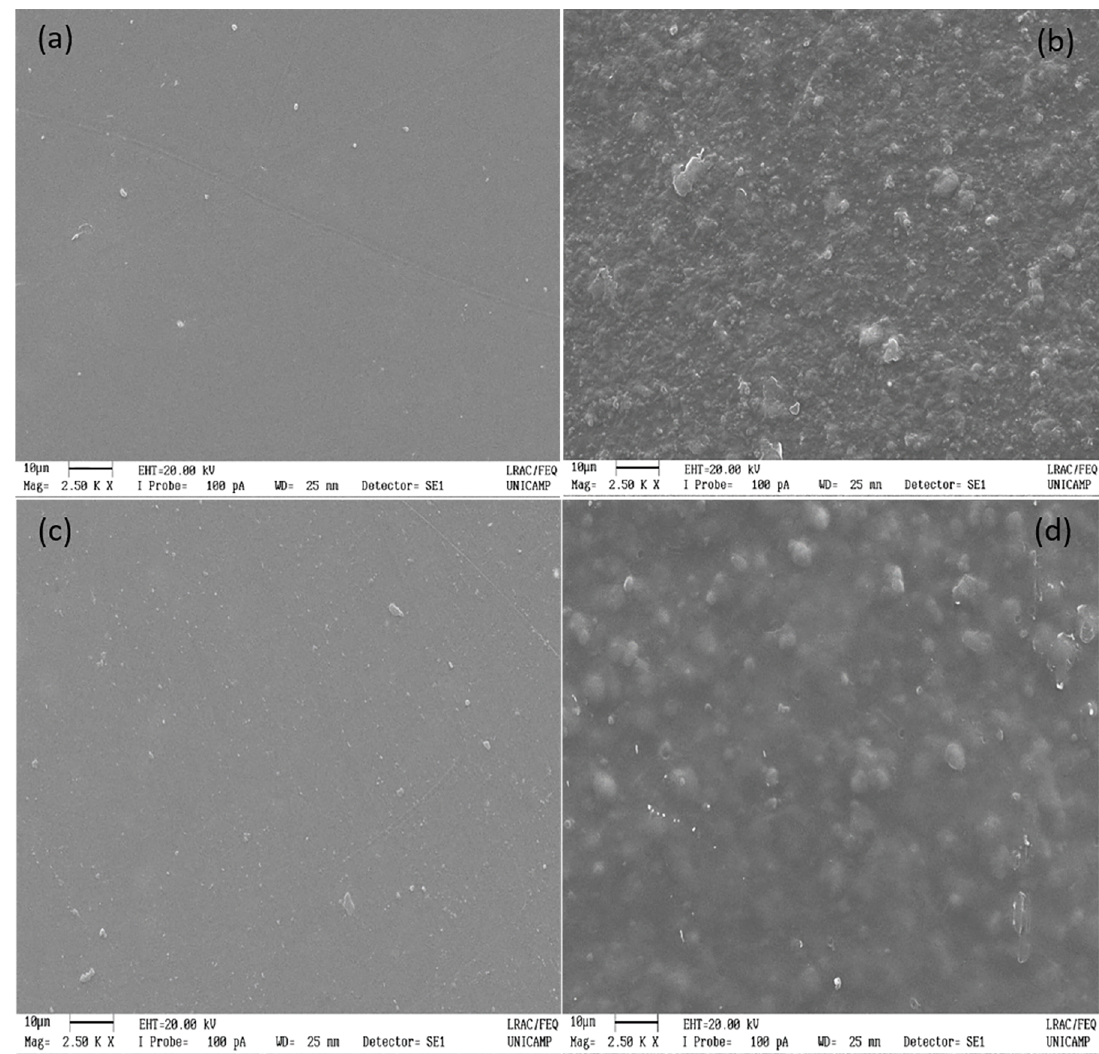
Figure 1. Scanning electron micrographs of (a) CHI; (b) 1/2 mPEG-PCL/ CHI; (c) CHI - GE; (d) 1/2 mPEG-PCL/ CHI - GE.